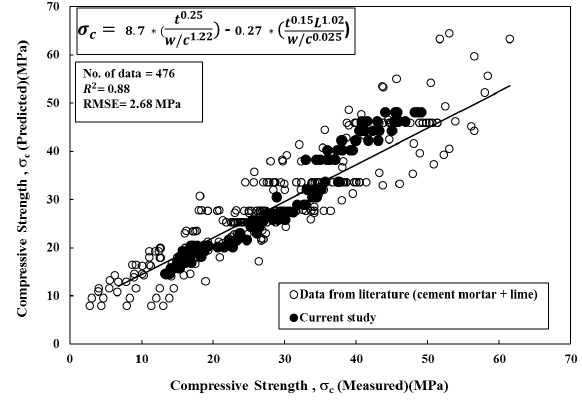
Figure 11: Comparison between measured and predicted of com- pressive strength for cement mortar modified with lime